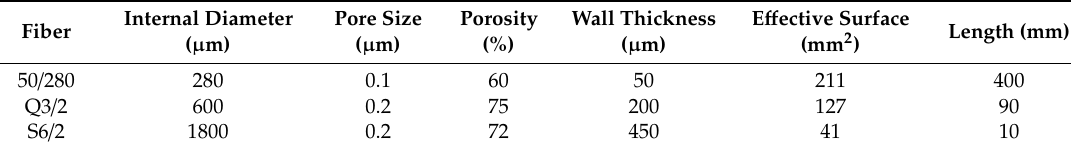
Table 1. Physical characteristics of the hollow fibers used in this